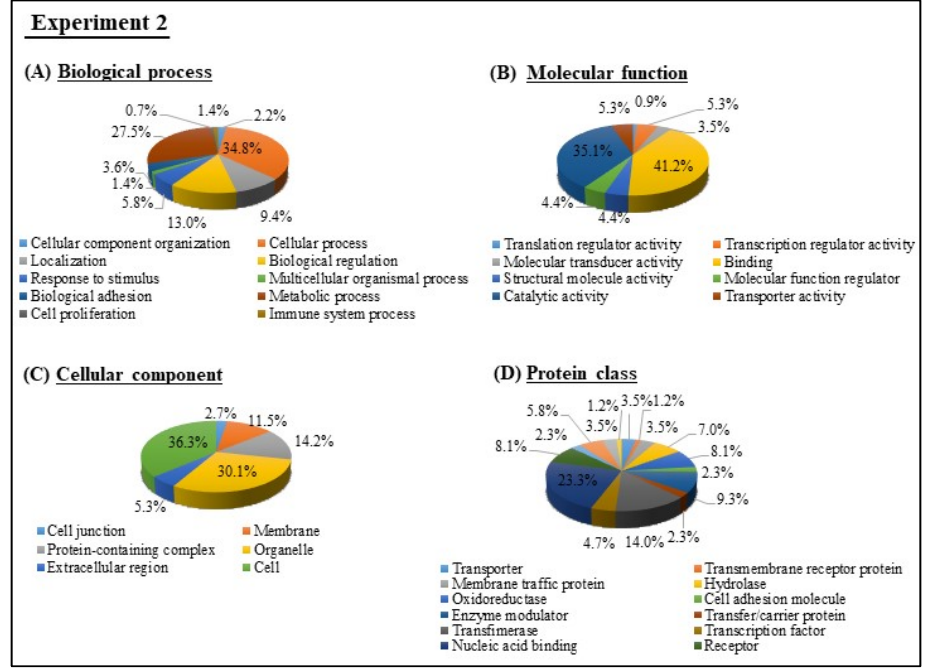
Figure 5. GO of DEGs in milk EVs from BLV-infected cattle with HPL + HLDH in Experiment 2 were analyzed and categorized according to biological processes ( A ), molecular functions ( B ), cellular components ( C ), and protein class ( D ), using PANTHER analysis.